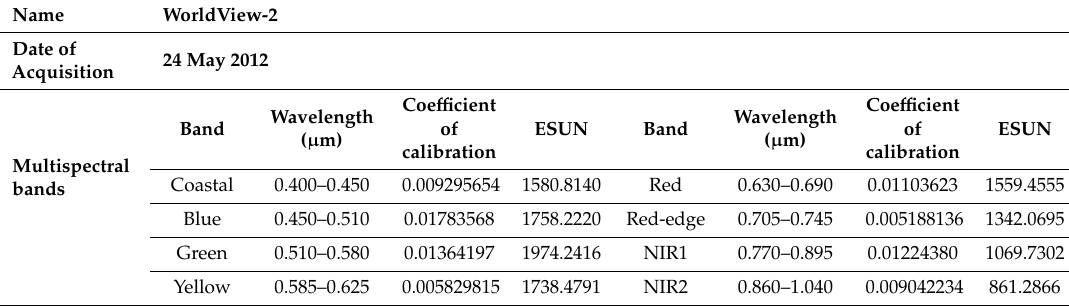
Table 1. Specification and parameters of WV2 image used in this research. The unit of coe ffi cient